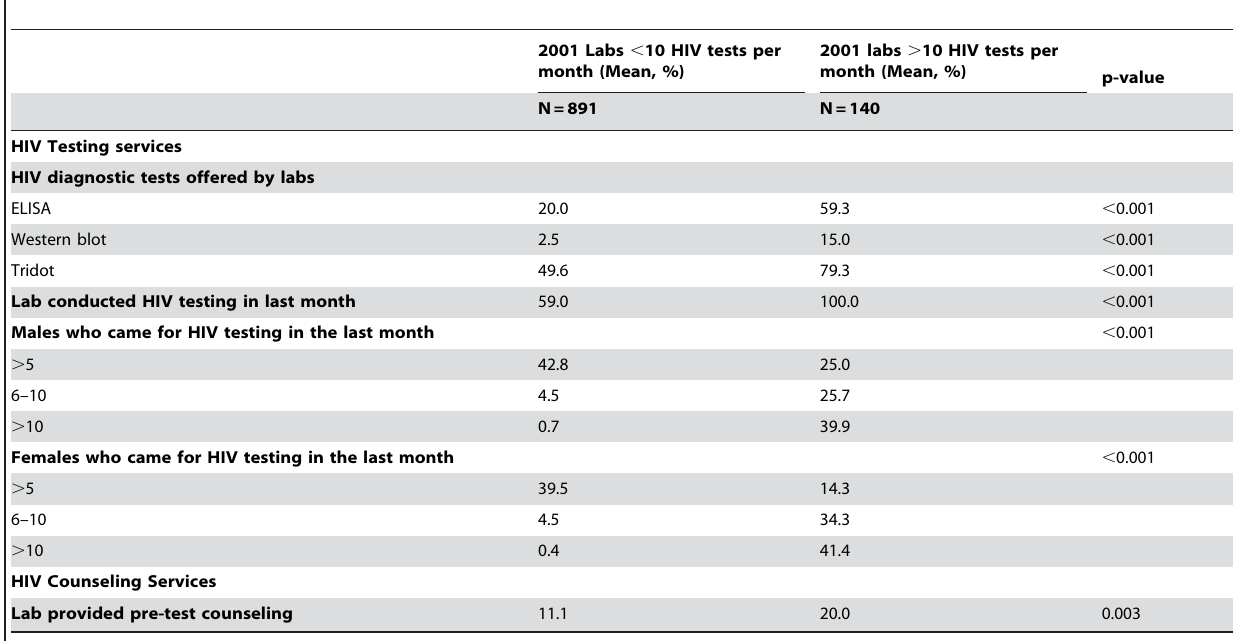
Table 1. HIV testing and counseling services in 2001 among low volume ( , 10 HIV tests per month) and high volume laboratories ( . 10 HIV tests per month) (N=